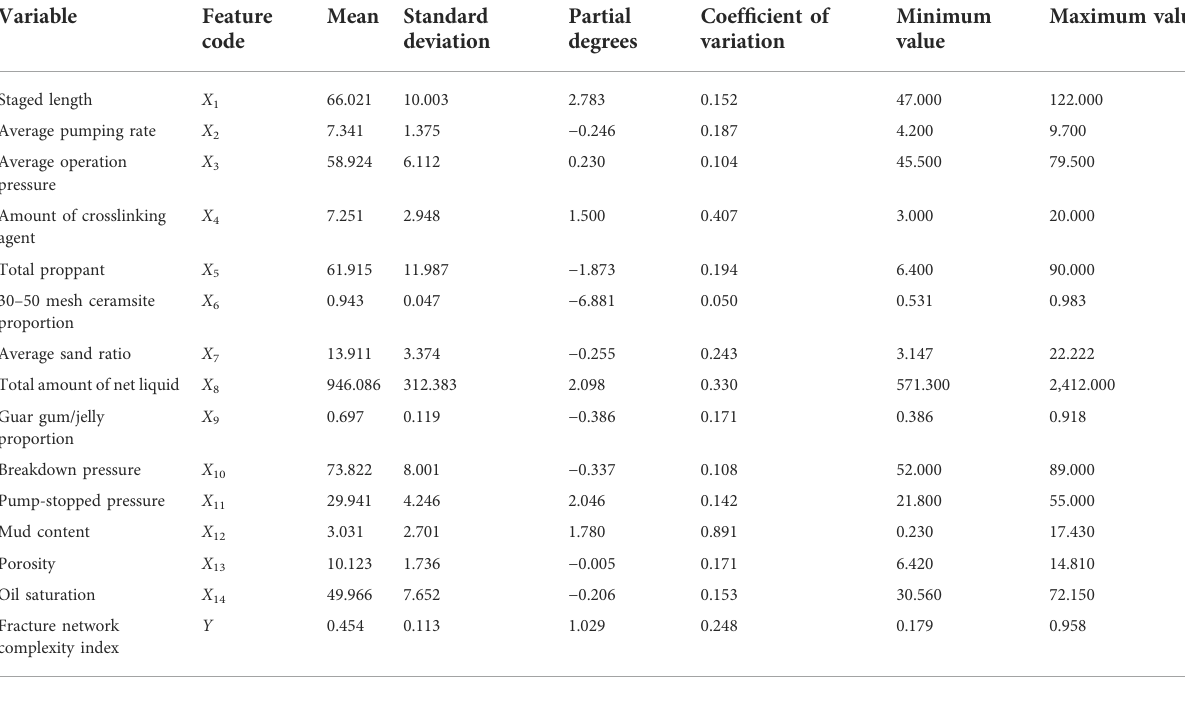
TABLE 2 Characteristic parameter calculation